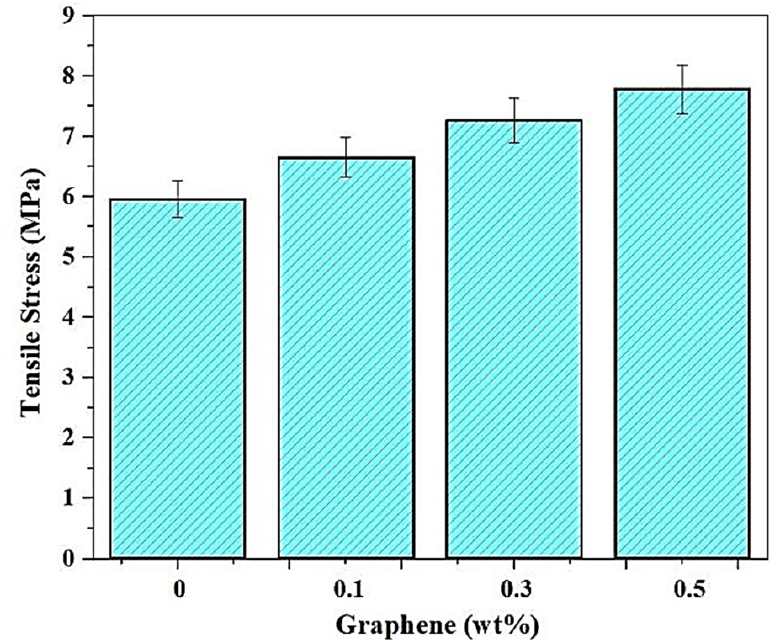
Figure 14. Variation of Tensile strength with the addition of Graphene.